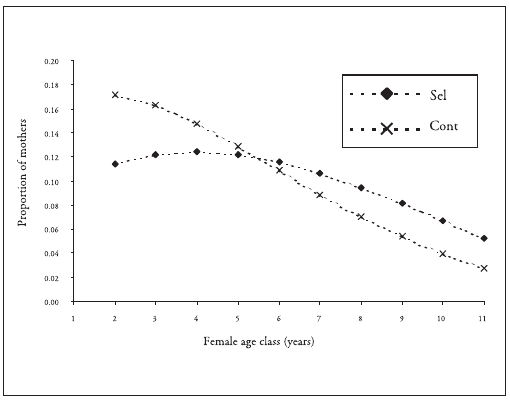
Fig. 2. Equilibrium age distributions of mothers in Sel and